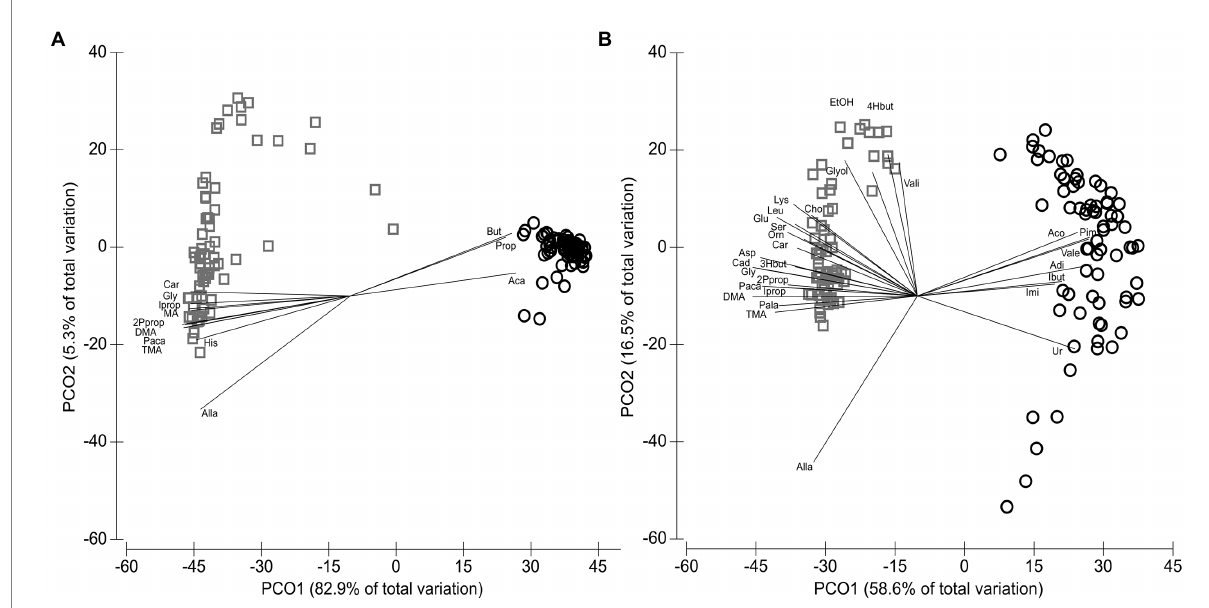
FIGURE 6 Distribution of metabolites identified by NMR analysis. (A) Metabolites of the animal’s rumen fluid (RUM, circles, N = 71) and duodenal fluid (DUO, squares, N = 67) samples including Spearman’s correlation vector (Spearman’s r ≥ 0.85). (B) Metabolites of rumen (circles) and duodenal fluid (squares) samples including Spearman’s correlation vector ( r ≥ 0.65) and excluding acetate, propionate and butyrate. 2Pprop, 2-Phenylpropionate; 3Hbut, 3-Hydroxybutyrate; 4Hbut, 4-Hydroxybutyrate; Aca, Acetate; Aco, Acetone; Adi, Adipate; Alla, Allantoin; Asp, Aspartate; But, Butyrate; Cad, Cadaverine; Car, Carnitine; Cho, Choline; DMA, Dimethylamine; EtOH, Ethanol; Glut, Glutamate; Gly, Glycine; Glyol, Glycerol; Ibut, Isobutyrate; Imi, Imidazole; Iprop, Isopropanol; Leu, Leucine; Lys, Lysine; Orn, Ornithine; Paca, Phenylacetate; Pala, Phenylalanine; Pim, Pimelate; Ser, Serine; TMA, Trimethylamine; Ur, Urea; Vale, Valerate; Vali,